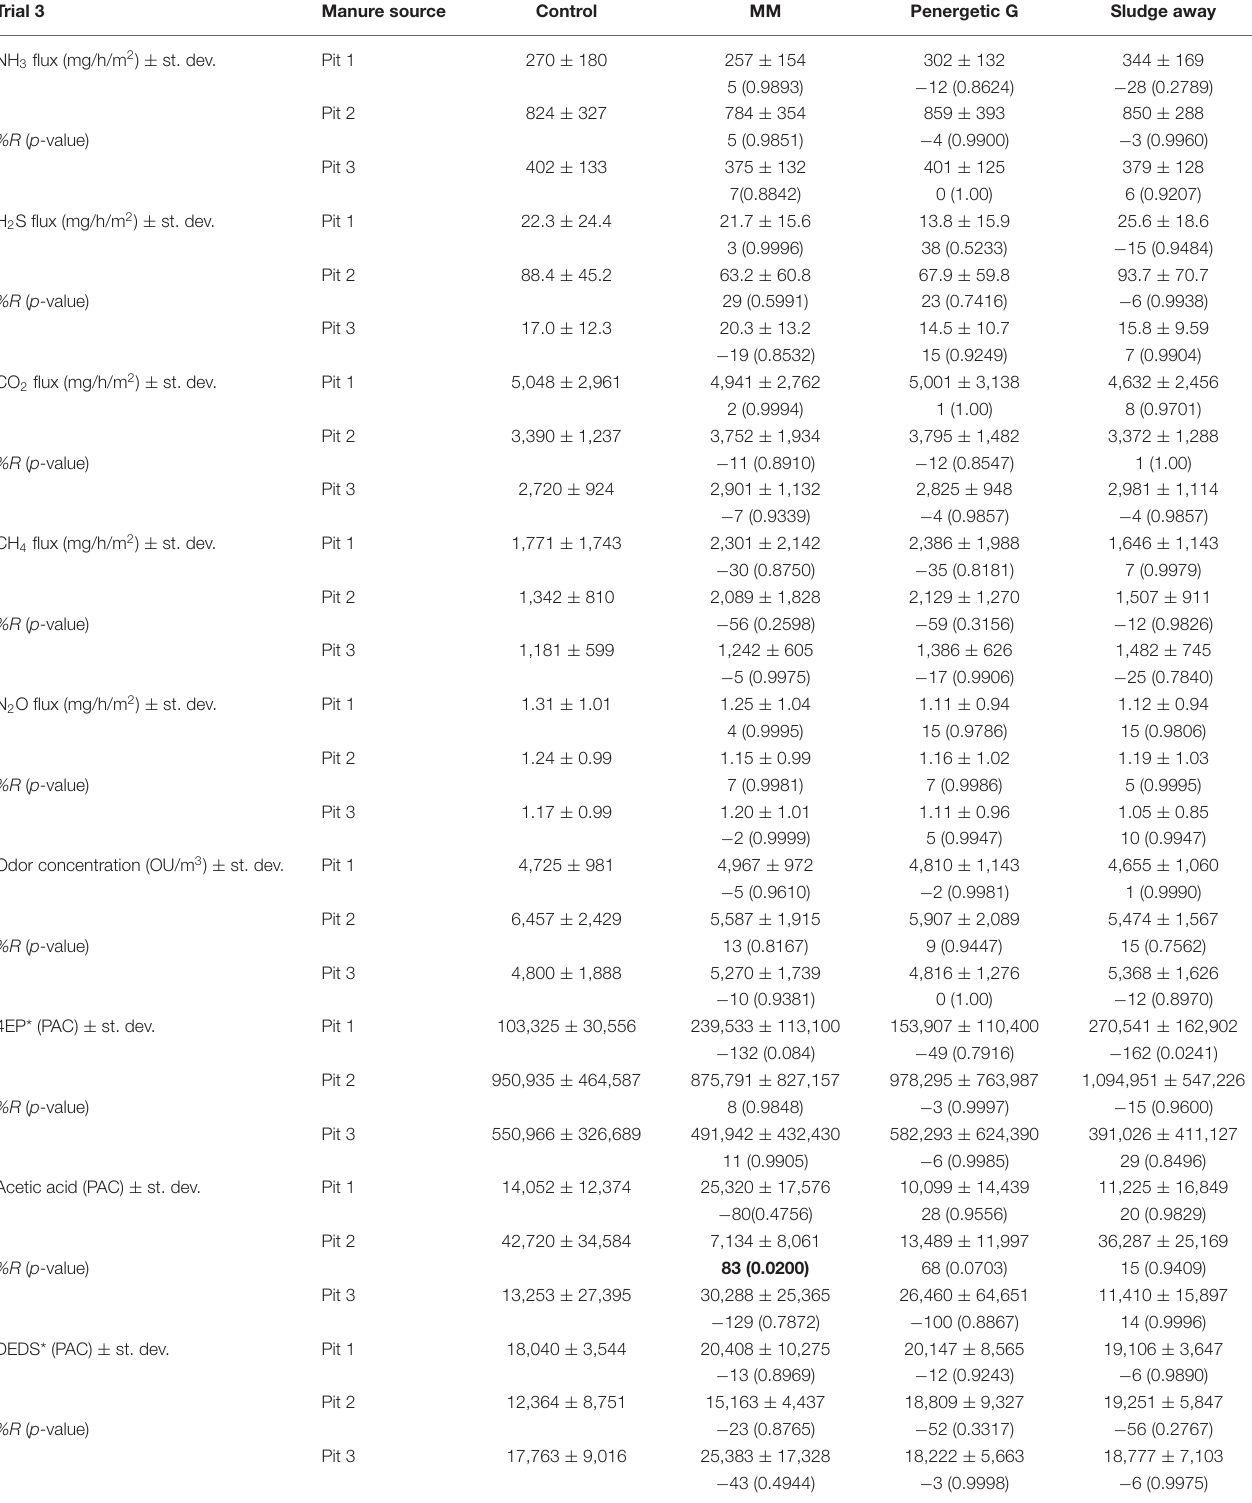
TABLE 7 | Trial 3-comparison of gaseous emissions from each of the 3 manure sources (farms) with their standard deviations. Trial 3 Manure source